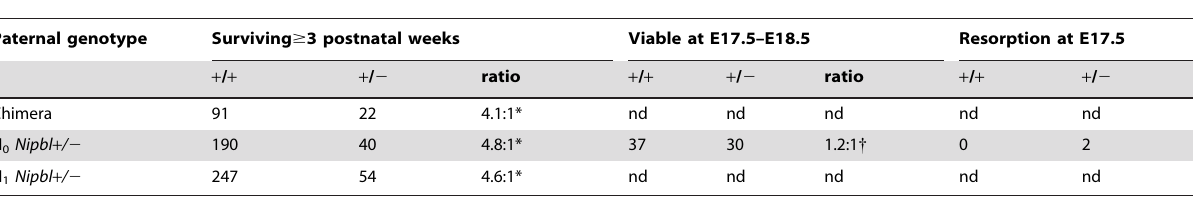
Table 1. Heterozygosity for Nipbl causes postnatal lethality.